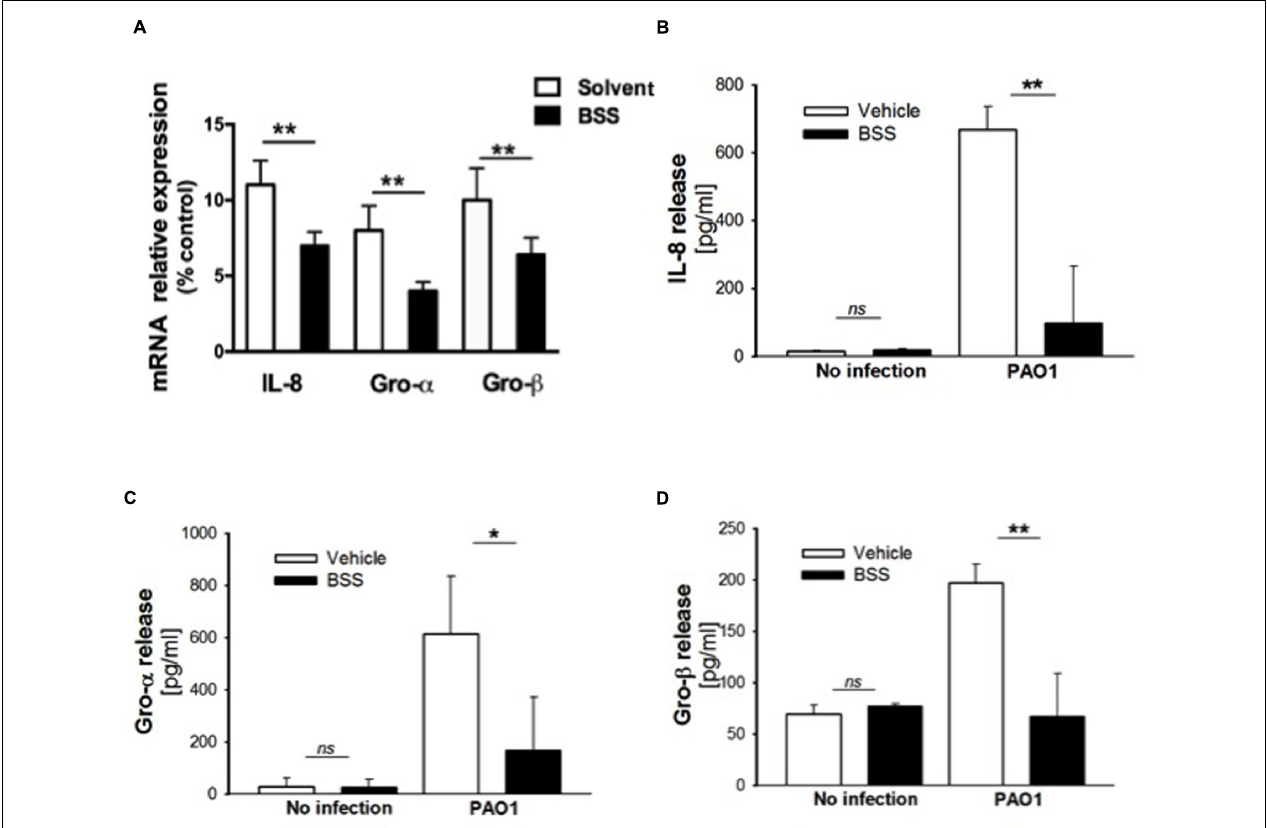
FIGURE 6 | Effect of BSS on expression of neutrophil chemokines in CuFi-1 cells. (A) CuFi-1 cells were treated for 16 h with solvent alone or 100 nM BSS and then infected by PAO1 (10–50 CFU/cell) for 4 h. mRNA expression was measured as indicated in the legend of Figure 2 . (B–D) Release of the neutrophil chemokines IL-8, Gro α , and GRO β in the supernatants of CuFi-1 cells were measured by Bio-plex assay. CuFi-1 cells were treated as described for (A) . Representative of at least three experiments performed in